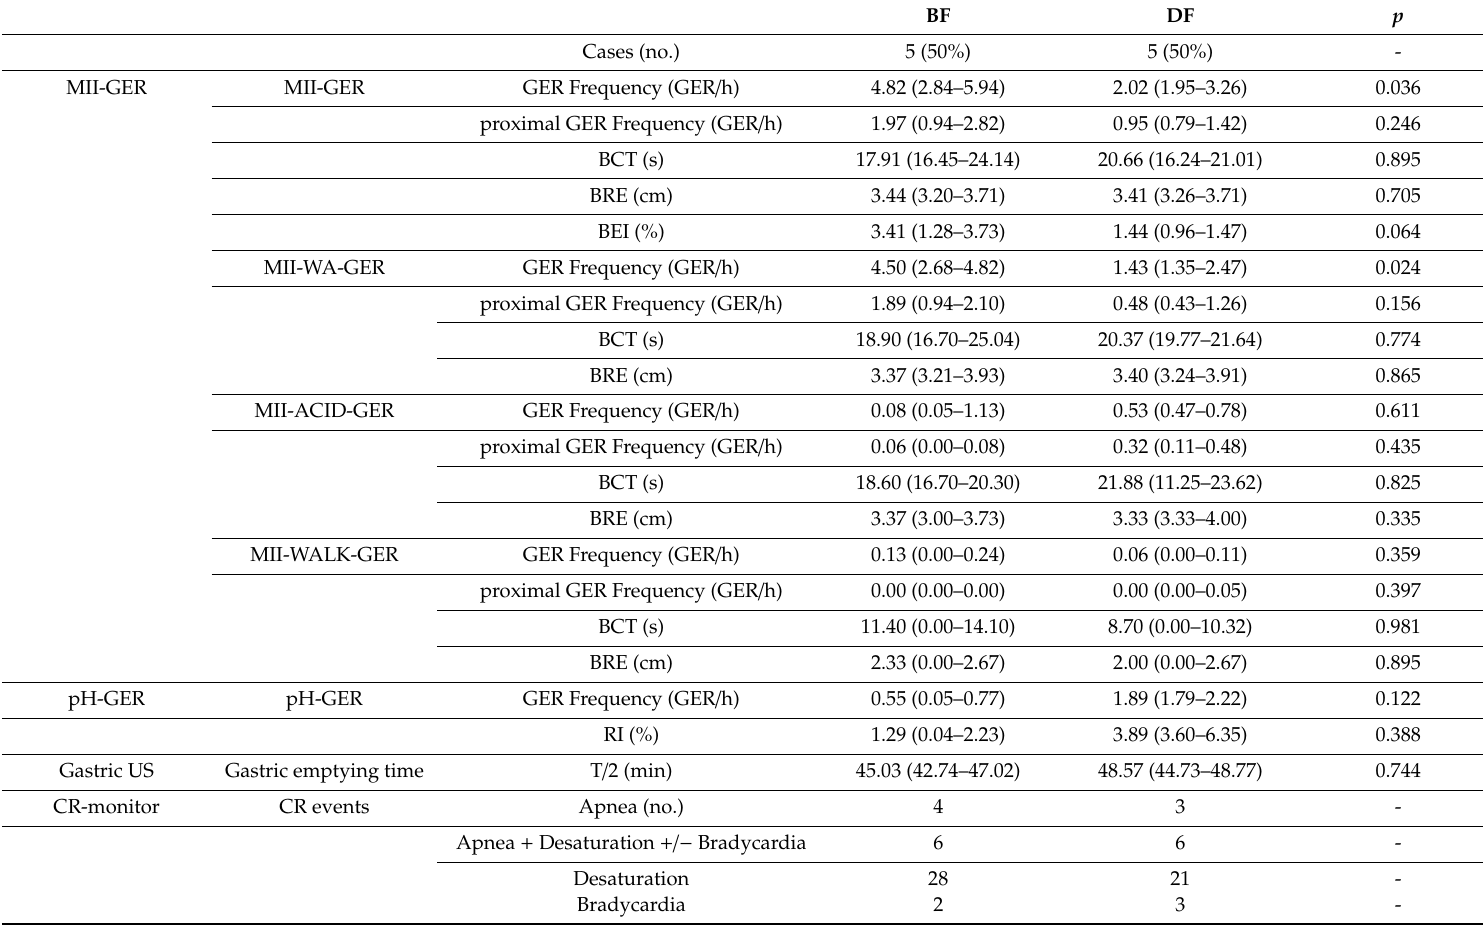
Table 3. MII / pH, gastric US, and CR monitoring data. Comparison between BF arm and DF